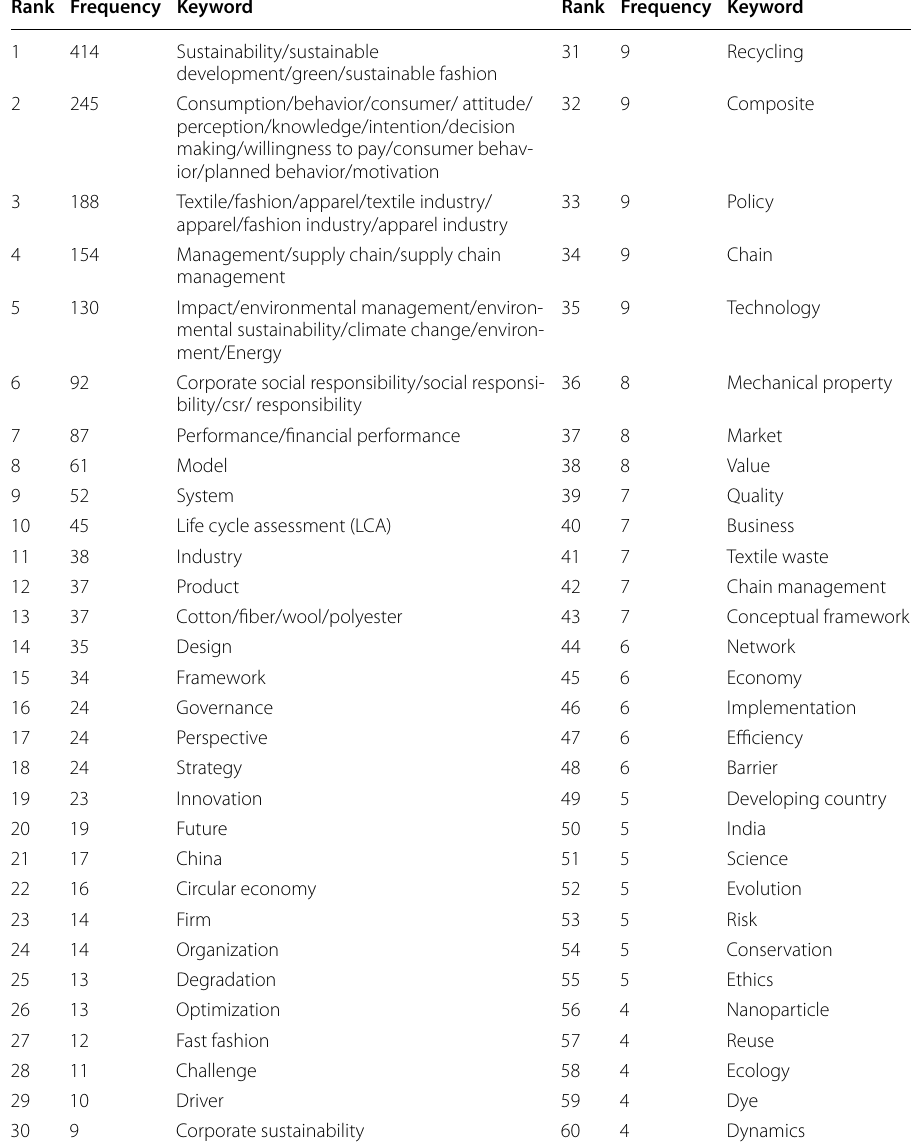
apparel industry